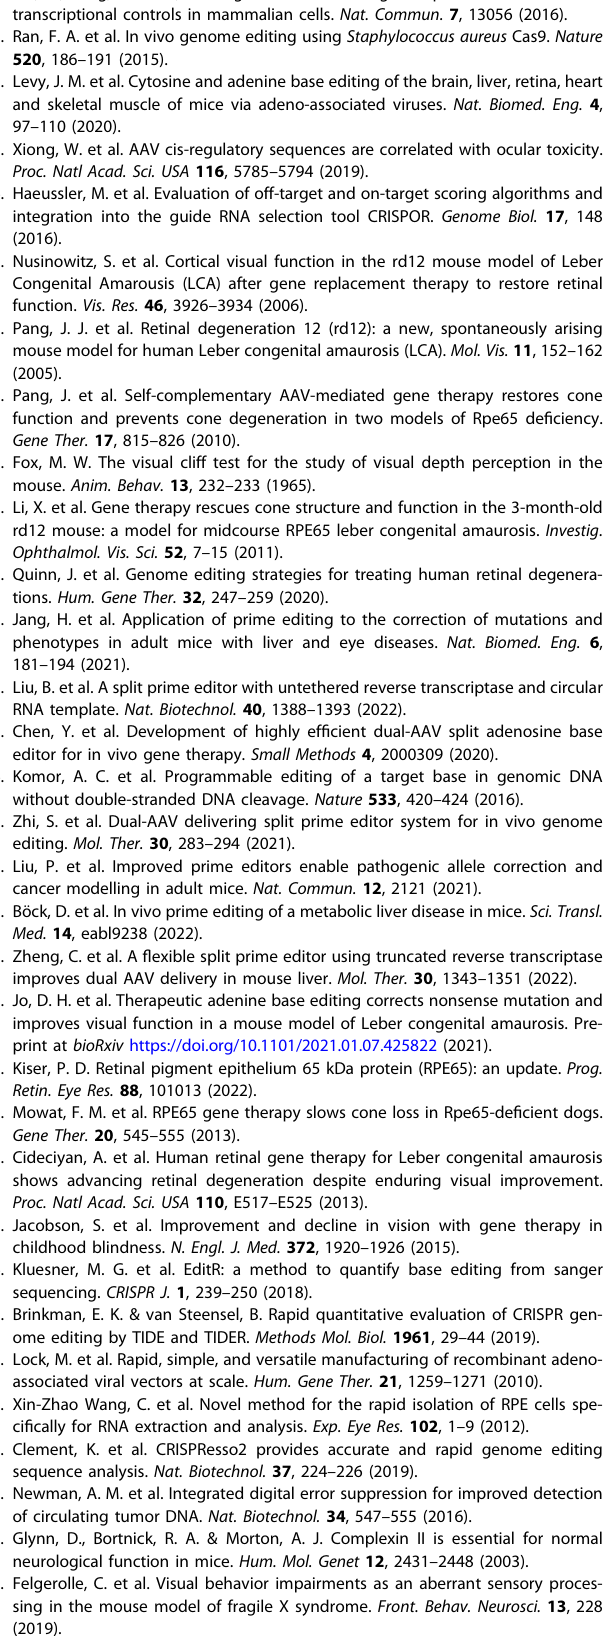
fi eld composed of two equal sections: the section with the checkboard pattern on the top of the fi rst box (length: 45 cm; width: 20 cm), called the “ safe zone ” (or “ shallow end ” ), and the section with a cliff between the transparent bottom of the top box and the checkerboard-patterned bottom, called the “ unsafe zone ” (or “ deep end ” ). Homogenous luminance in the apparatus was set at 10 lux at the height of the mouse eyes. During the test, a mouse was left free to roam the entire open fi eld for 300 s after being set up in the corner of the shallow end section. Its behavior was recorded by a video camera, and the time the test animals spent in the safe or unsafe zone was analyzed by ANY maze software (Global Biotech Inc., Shanghai, China). Between each mouse, the device was cleaned with water and 70% ethanol. All analyses were performed by a single operator who was blinded to mouse genotypes and treatment. Statistical analysis The statistical tests used for each experiment are stated in the corresponding fi gure legends. Statistical analysis was performed using GraphPad Prism (University of California, San Diego,